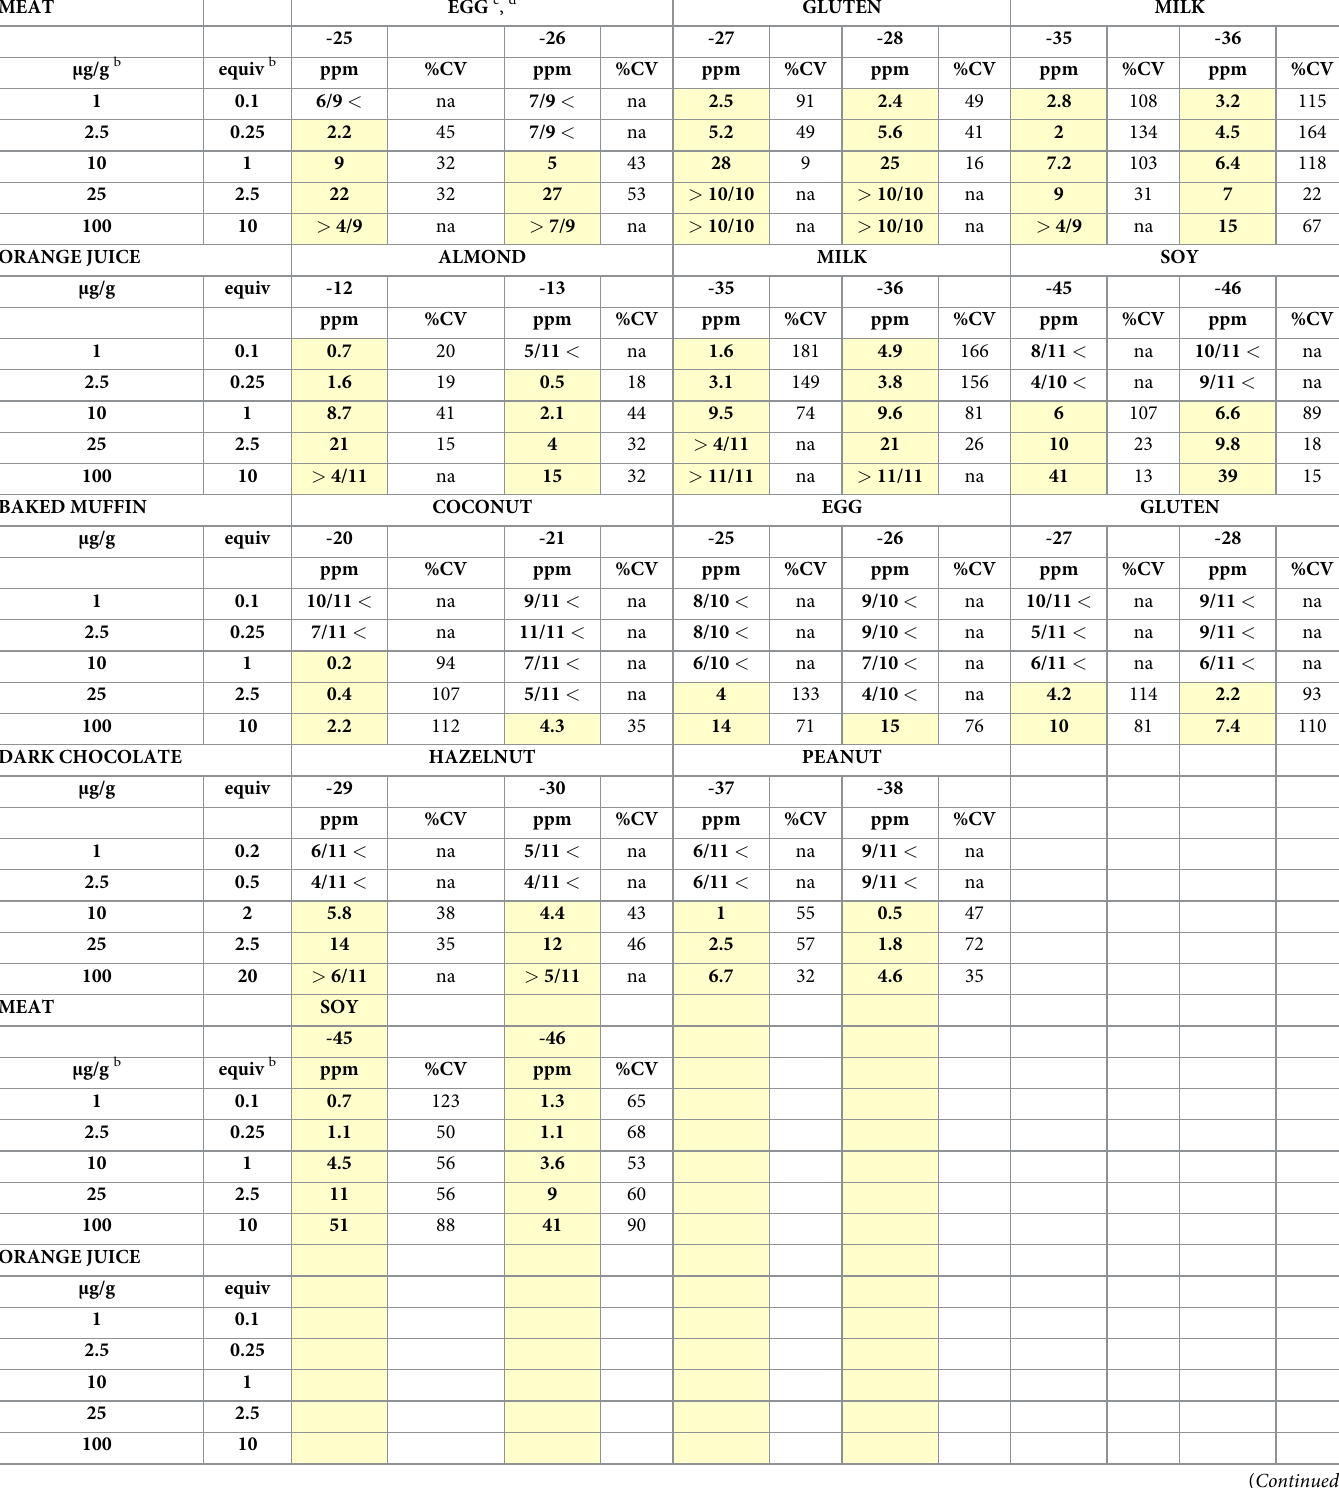
Table 15. Average interpolated allergenic food concentrations incurred in food samples a .